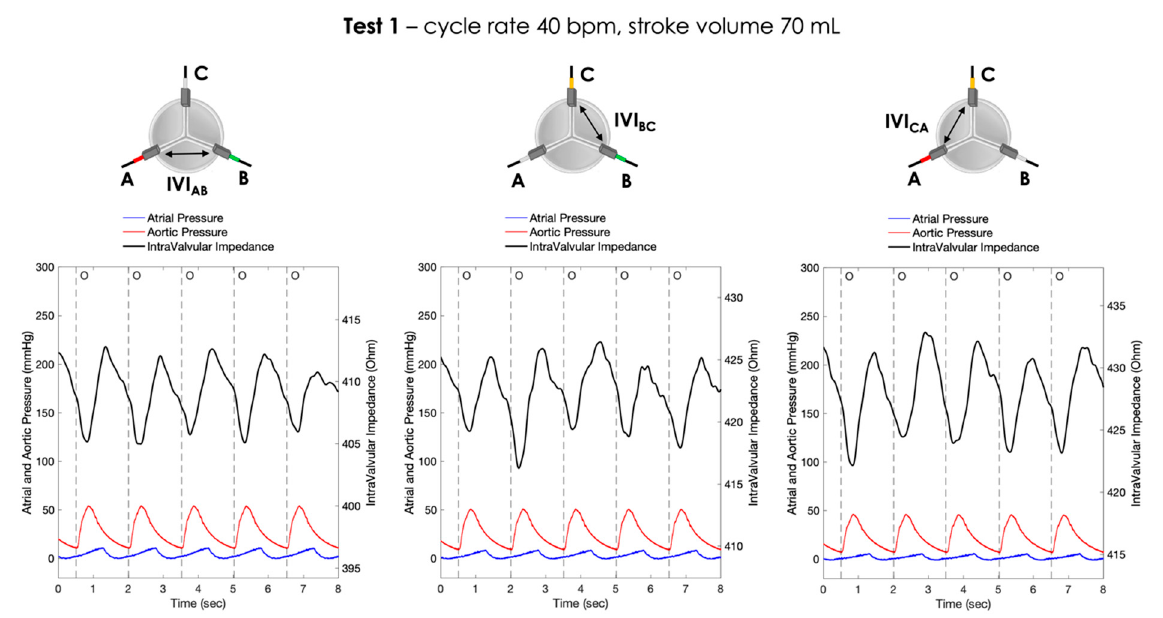
Figure 6. Atrial pressure, aortic pressure and IVI signal recorded inside the porcine heart for the three pairs of electrodes during Test 1 (cycle rate 40 bpm, stroke volume 70 mL): AB ( left ), BC ( center ) and CA ( right ). O = start of valve opening identified with the low peak of the aortic pressure.